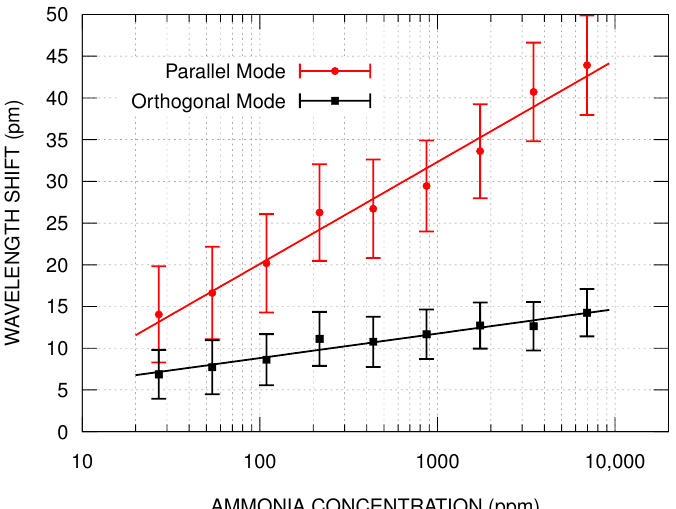
Figure 6. Calibration curves of parallel and orthogonal modes of the sensor in the presence of ammonia vapor with concentration ranging from 27ppm to 6960ppm.